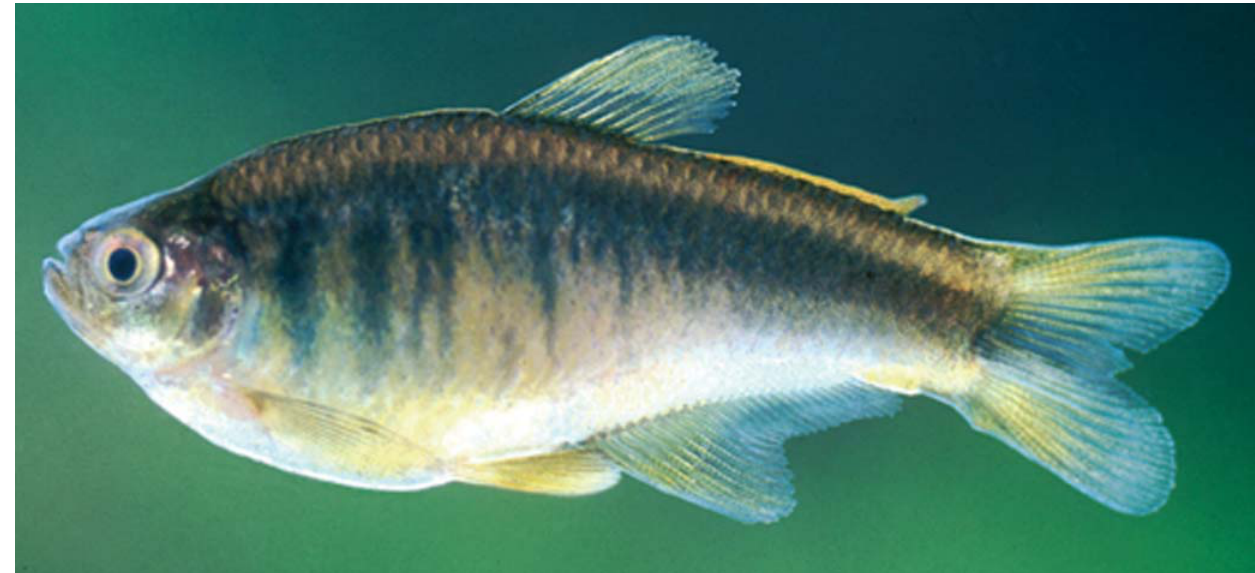
Fig. 3. Lophiobrycon weitzmani , paratype, adult male, LIRP 4338, 33.1 mm SL, Brazil, Minas Gerais, rio Grande basin, upper rio